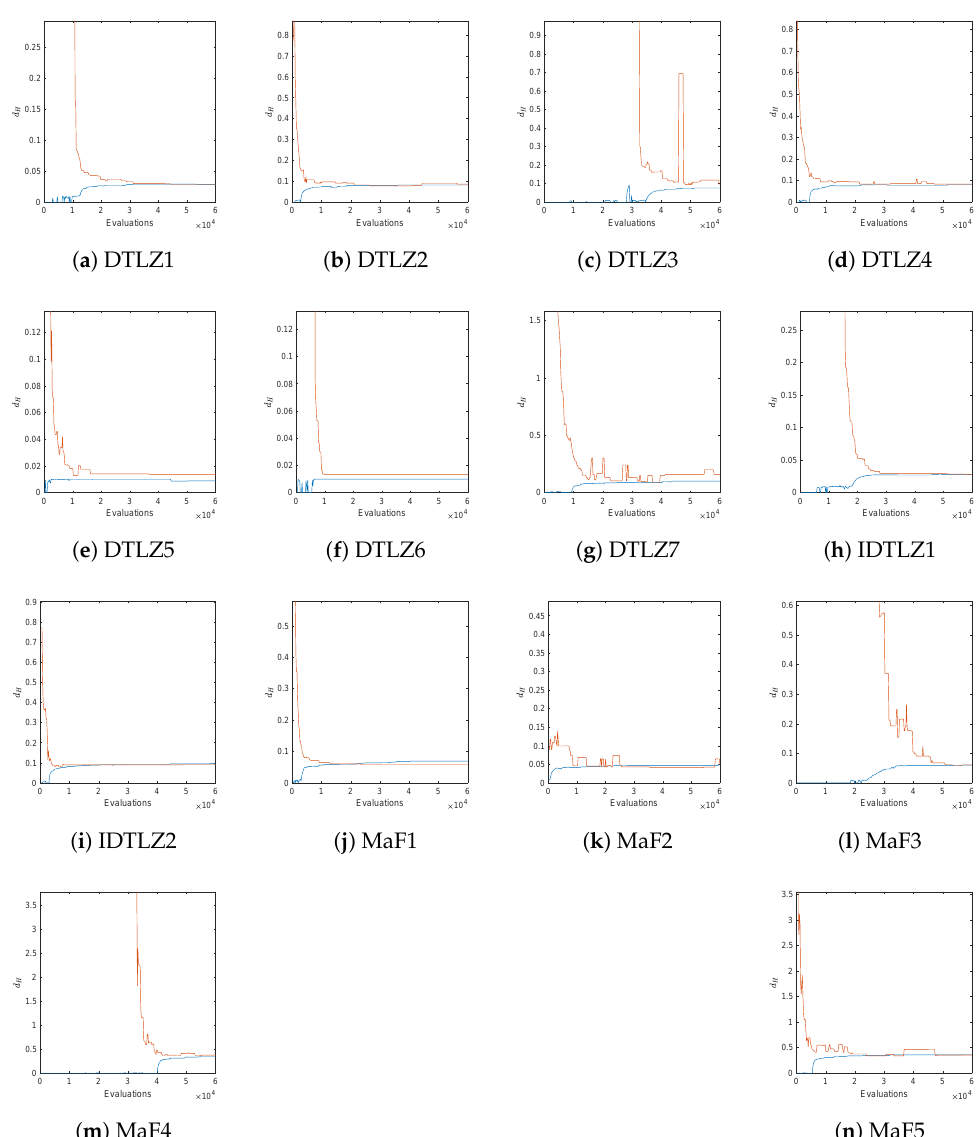
Figure A7. Evolution of the Hausdorff distances d H ( F ( A ) , F ( P Q )) of NSGA-II-A and the computed approximations ∆ for several test functions, using k = 3